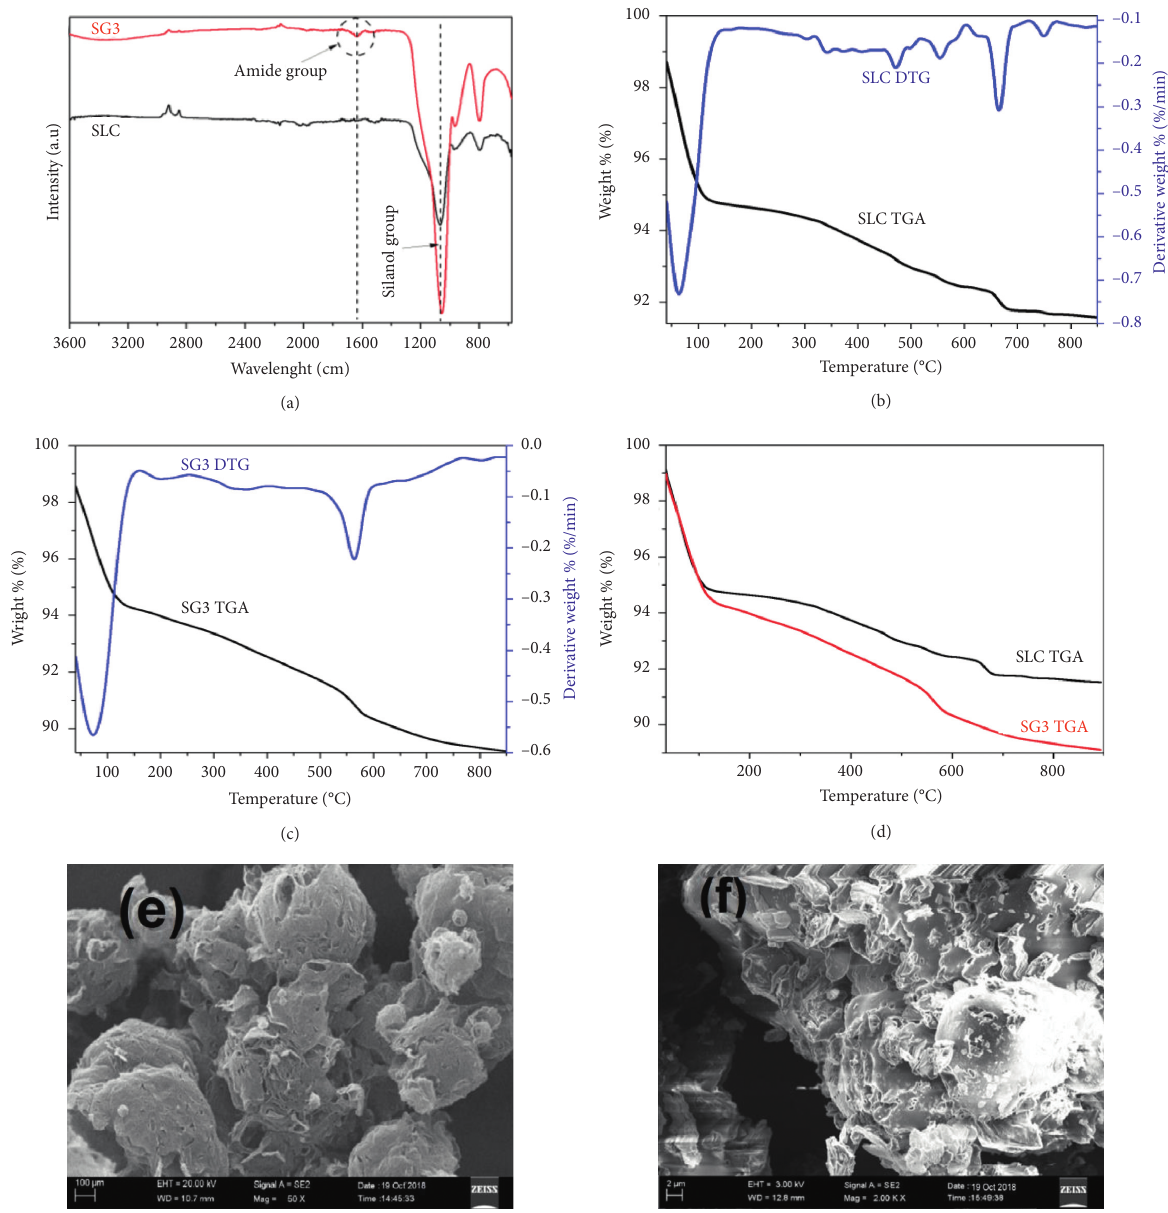
Figure 2: (a) FTIR spectra of pristine silica and G-3 PAMAM SGA; TGA and DTA spectra of (b) pristine silica and (c) G-3 PAMAM SGA; (d) comparison of TGA spectra for pristine silica and G-3 PAMAM SGA; SEM micrograph of G-3 PAMAM SGA (e) before and (f) after Cd 2+